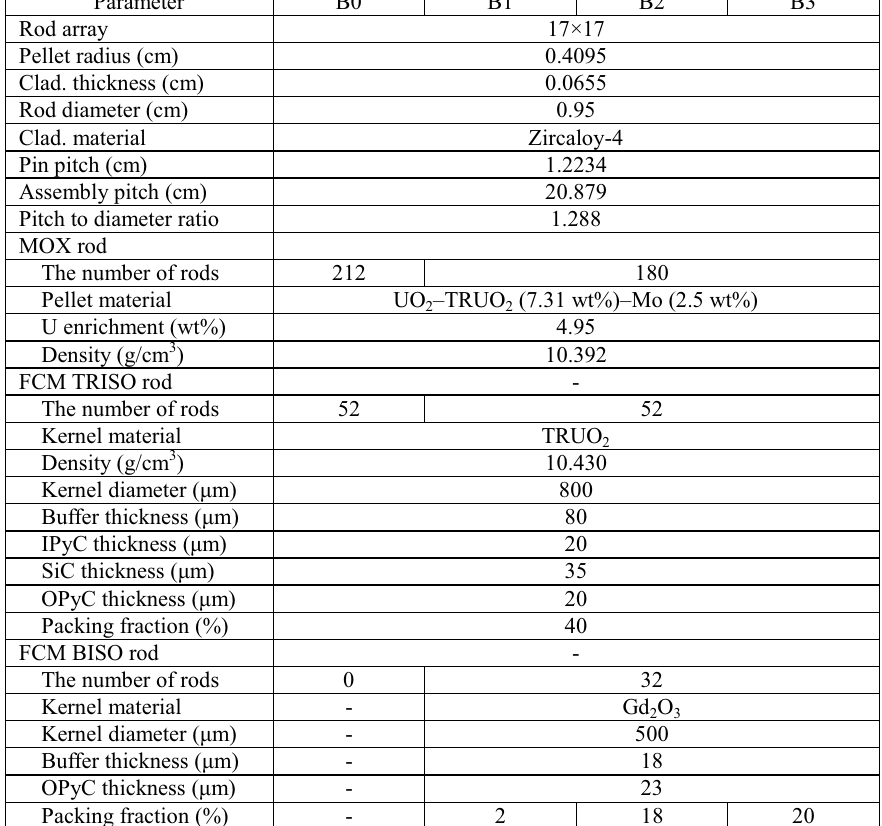
Table II. Design specifications of the fuel assemblies composed of MOX rods and FCM